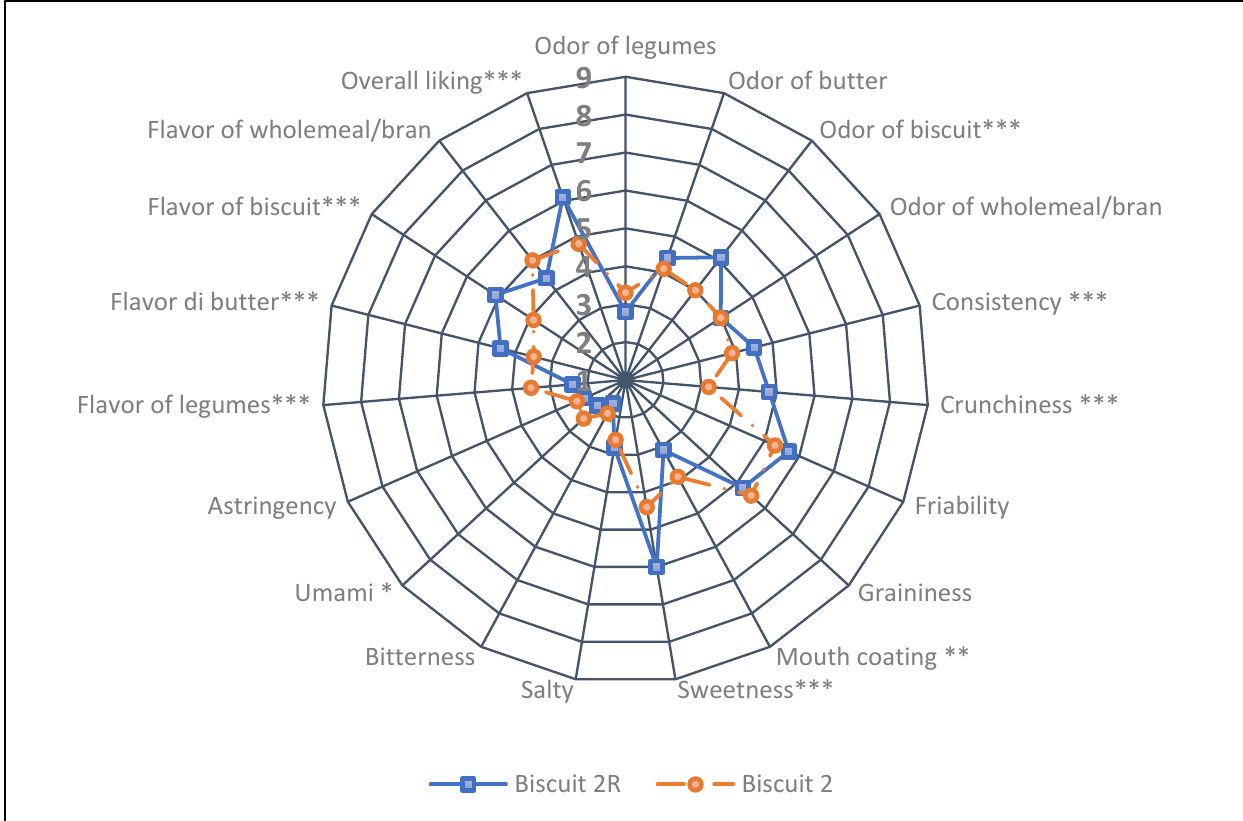
Figure 8. Sensorial profiles of type 2 Biscuits, without (2R) and with common bean flour (2). Data analyzed by ANOVA and post hoc test (Tukey’s HSD); *, **, *** indicate significant differences between the tested products at p < 0.1, p < 0.5 and p < 0.01, respectively.